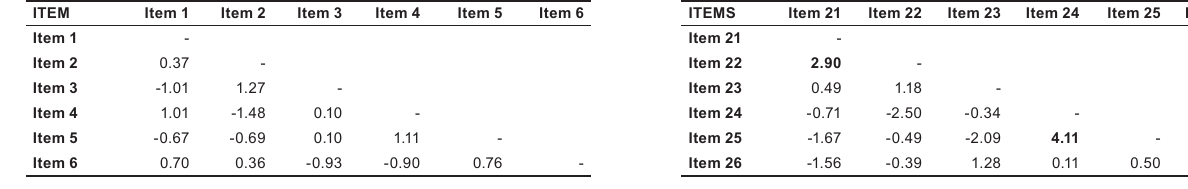
TABLE 5 Standardised residuals for Atmosphere dimension – Mall intercept study